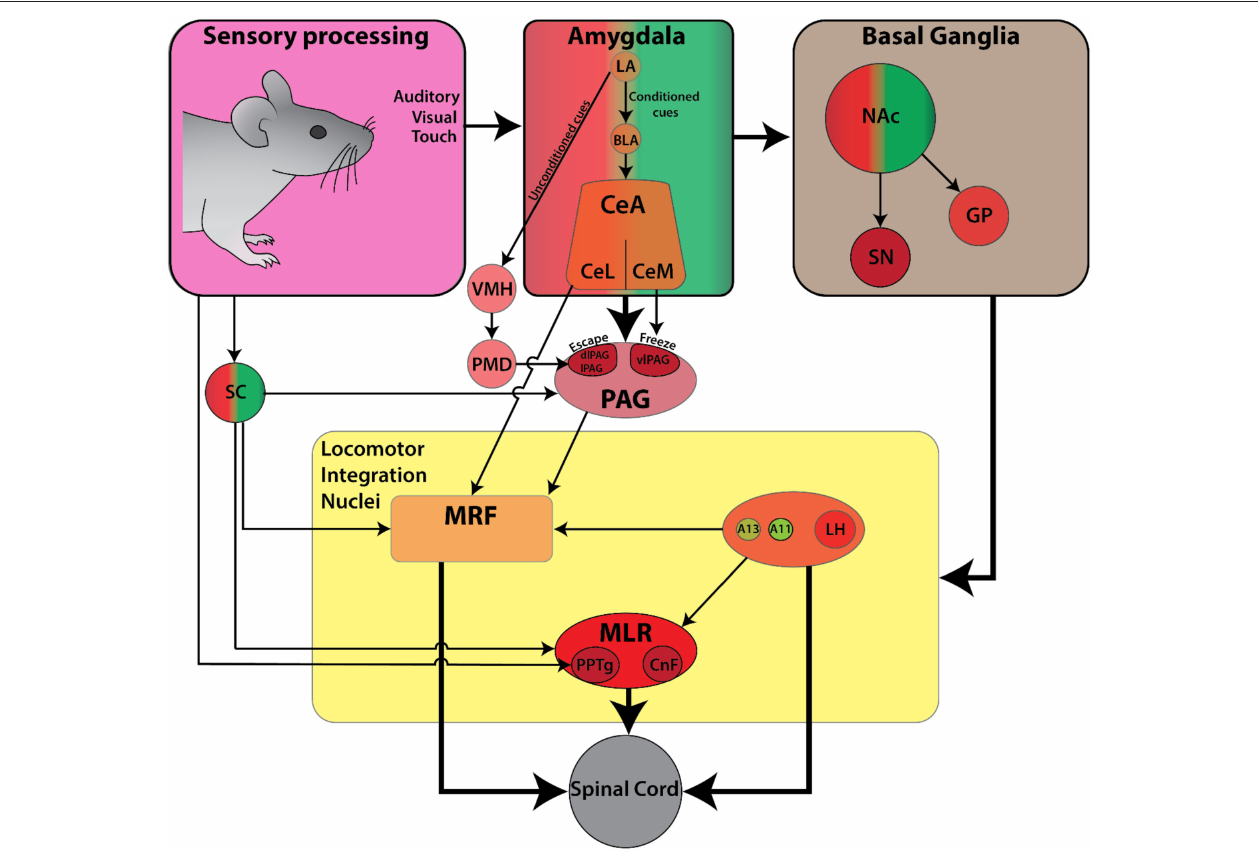
FIGURE 4 | Schematic diagram of the currently known descending connectivity of defensive (avoidance) locomotor control. (Complementary to Figure 2C . Some connections omitted for lack of data or complexity of connectivity). Ascending connectivity has been omitted for